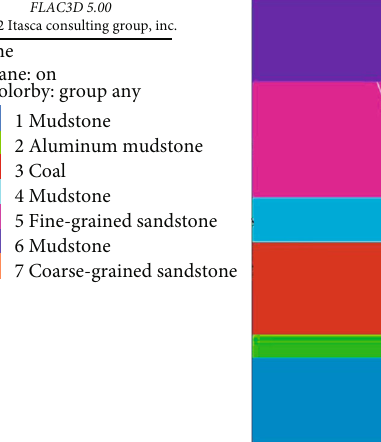
Figure 14: Simulated diagram of roof-breaking presplitting